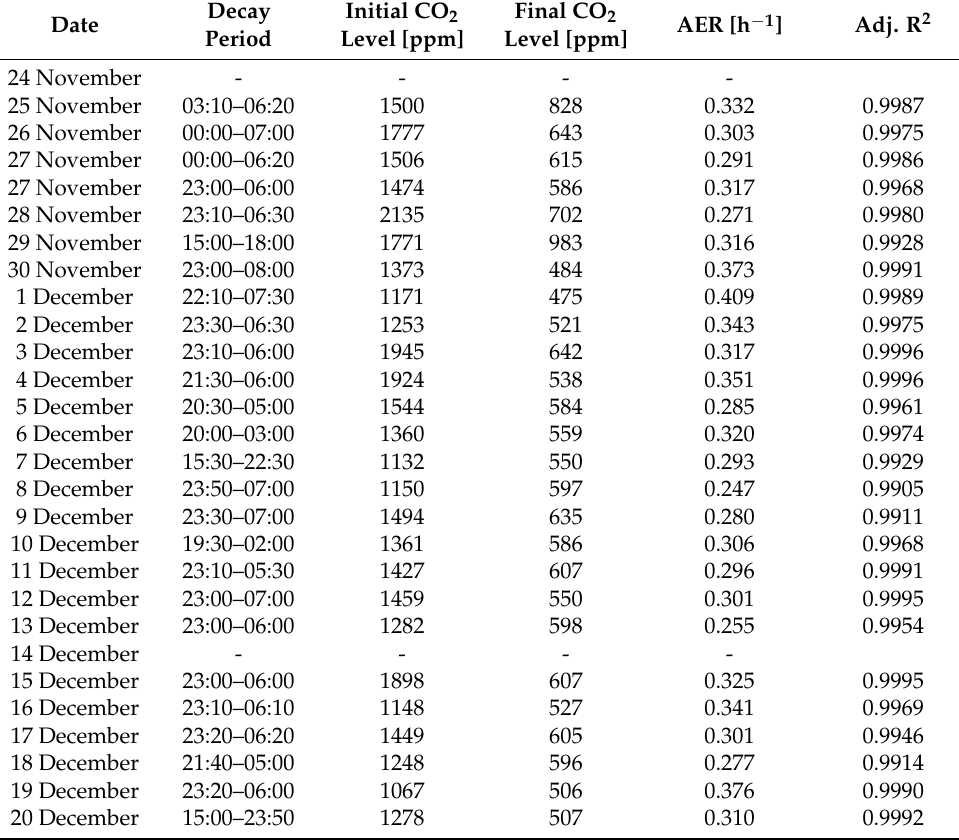
Table 2. Summary of AER calculated by using CO 2 decay method during unoccupied